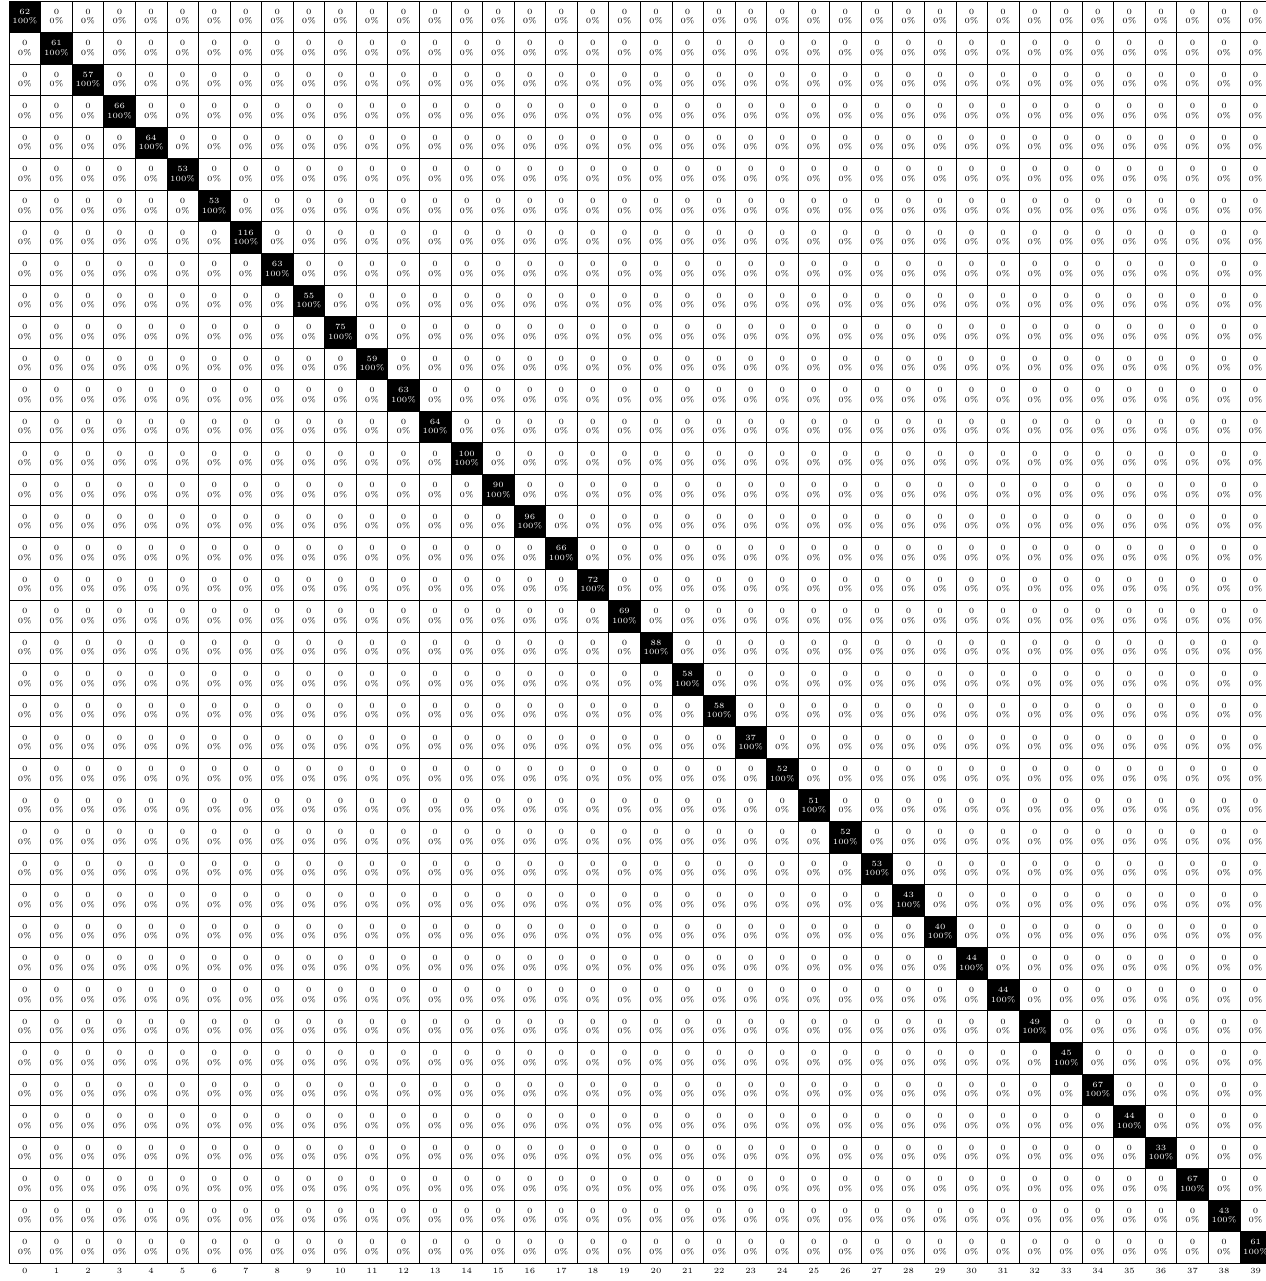
Figure 15. Confusion matrix for the Indian fruits dataset with ResNet 1D